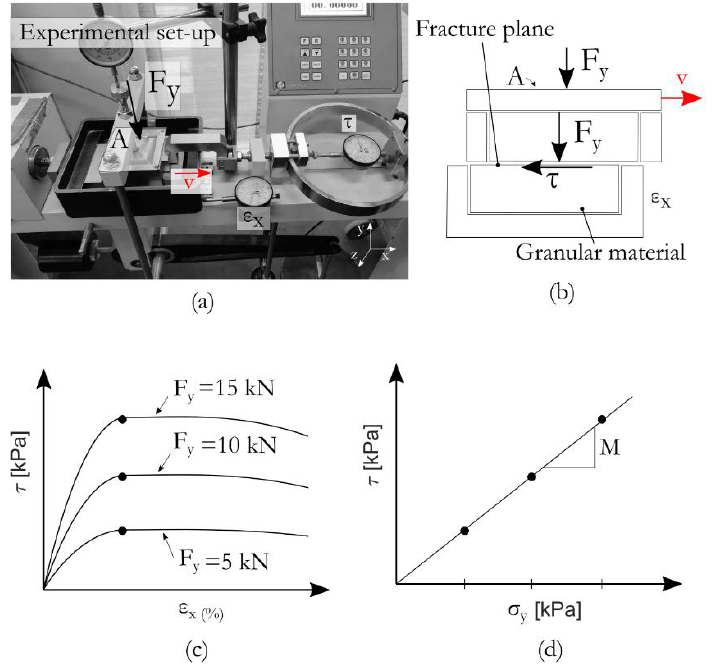
Figure 5. ( a )The direct shear cell, ( b ) the schematic illustration, ( c ) typical representation of shear test results and ( d ) friction angle calculation procedure.